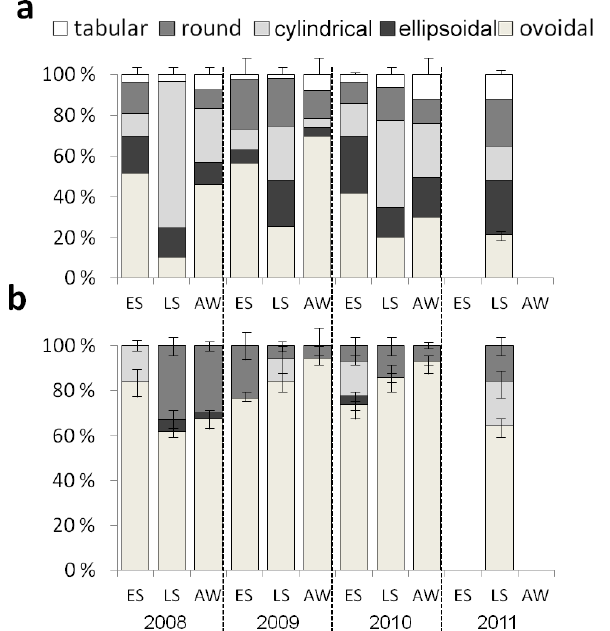
Figure 4. Percentage contribution of different FP types to total FP community between 2008 and 2011 at P3 (upper) and P2 (lower). Data is grouped according to season: ES stands for early season, LS for late season, AW for autumn–winter. Note: cylindrical at- tributable to krill and large copepods, tabular to salps, ovoidal to small copepods and pteropods, round to small copepods and am- phipods, and ellipsoidal to larvaceans. Error bars indicate the stan- dard error of the mean.